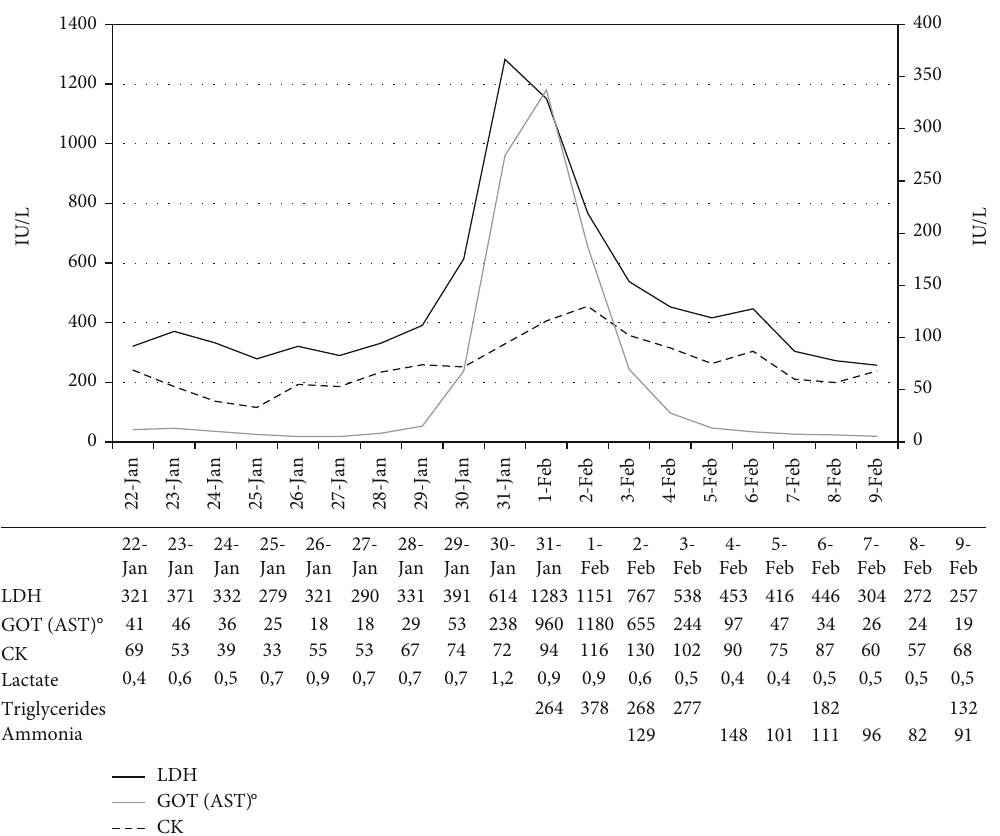
Figure 1: Laboratory investigations. Normal range: LDH < 250IU/L , AST 19-48 IU/L, CK 20-200 UI/L, lactate 0.5-2.2mmol/L, triglycerides < 150mg/dL , ammonia < 90 μ g/dL